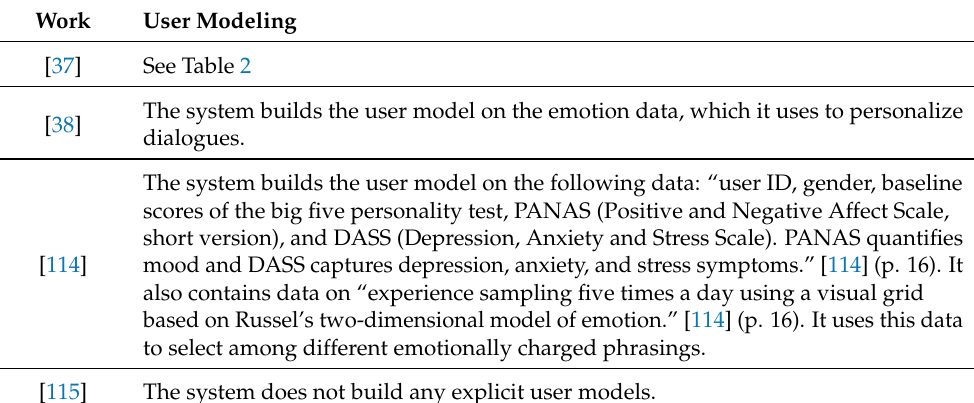
Table 7. Answering RQ6. What user modeling, especially for personalization and adaptation, do the systems